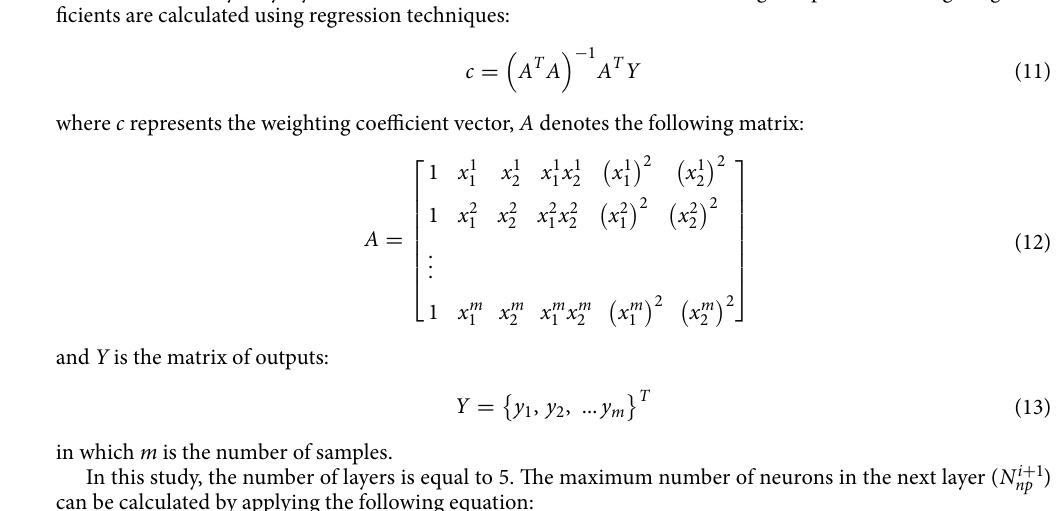
nected to neurons in the next layer. In other words, the GMDH algorithm generates the structure of the network through successive generations of quadratic regression polynomials with two input variables or neurons. In Fig. 2, a schematic plan of a five-layer GMDH with effective and ignored neurons is shown. The GMDH network is created and trained layer-by-layer and neuron-by-neuron. This strategy allows users to have access to the neurons’ information during the network training process. As can be seen in Fig. 2, in the second, third, and fourth layers, there are some ignored neurons. The ignoring of neurons and the selection of appropriate ones prevent the immense growth of the network. The number of ignored neurons in each middle layer is affected by the error evaluation criteria e.g. MSE criterion: